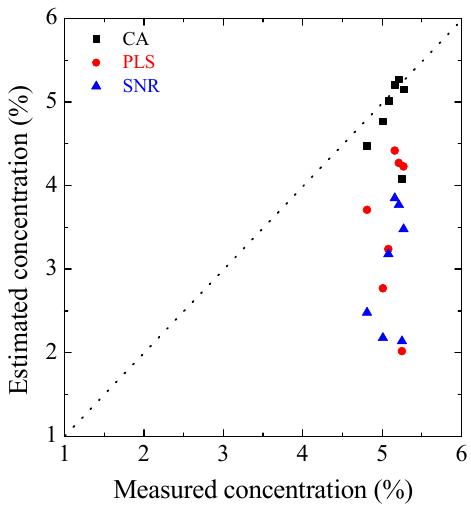
Figure 11. Estimated hydrogen concentration with CA, PLS, and SNR.